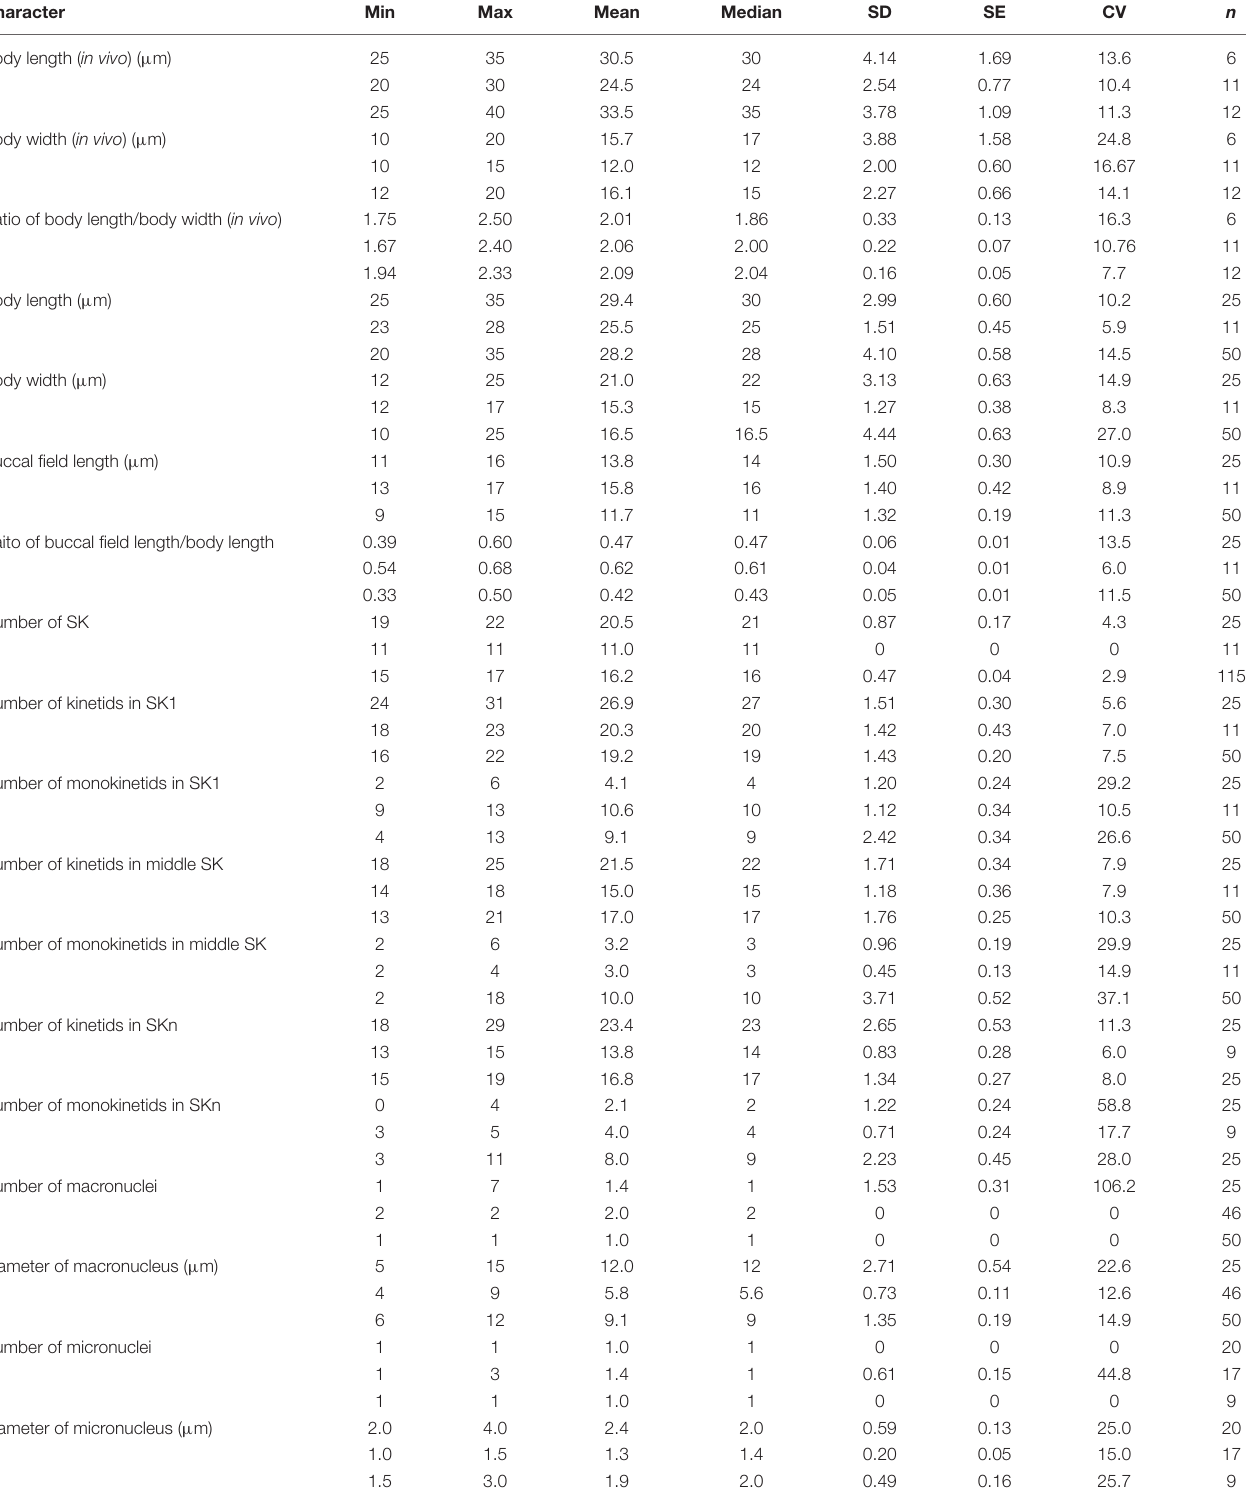
TABLE 1 | Morphometric data for Citrithrix smalli sp. nov. (upper row), Homalogastra binucleata sp. nov. (middle row) and Uronema orientalis Pan et al., 2015 (lower row).